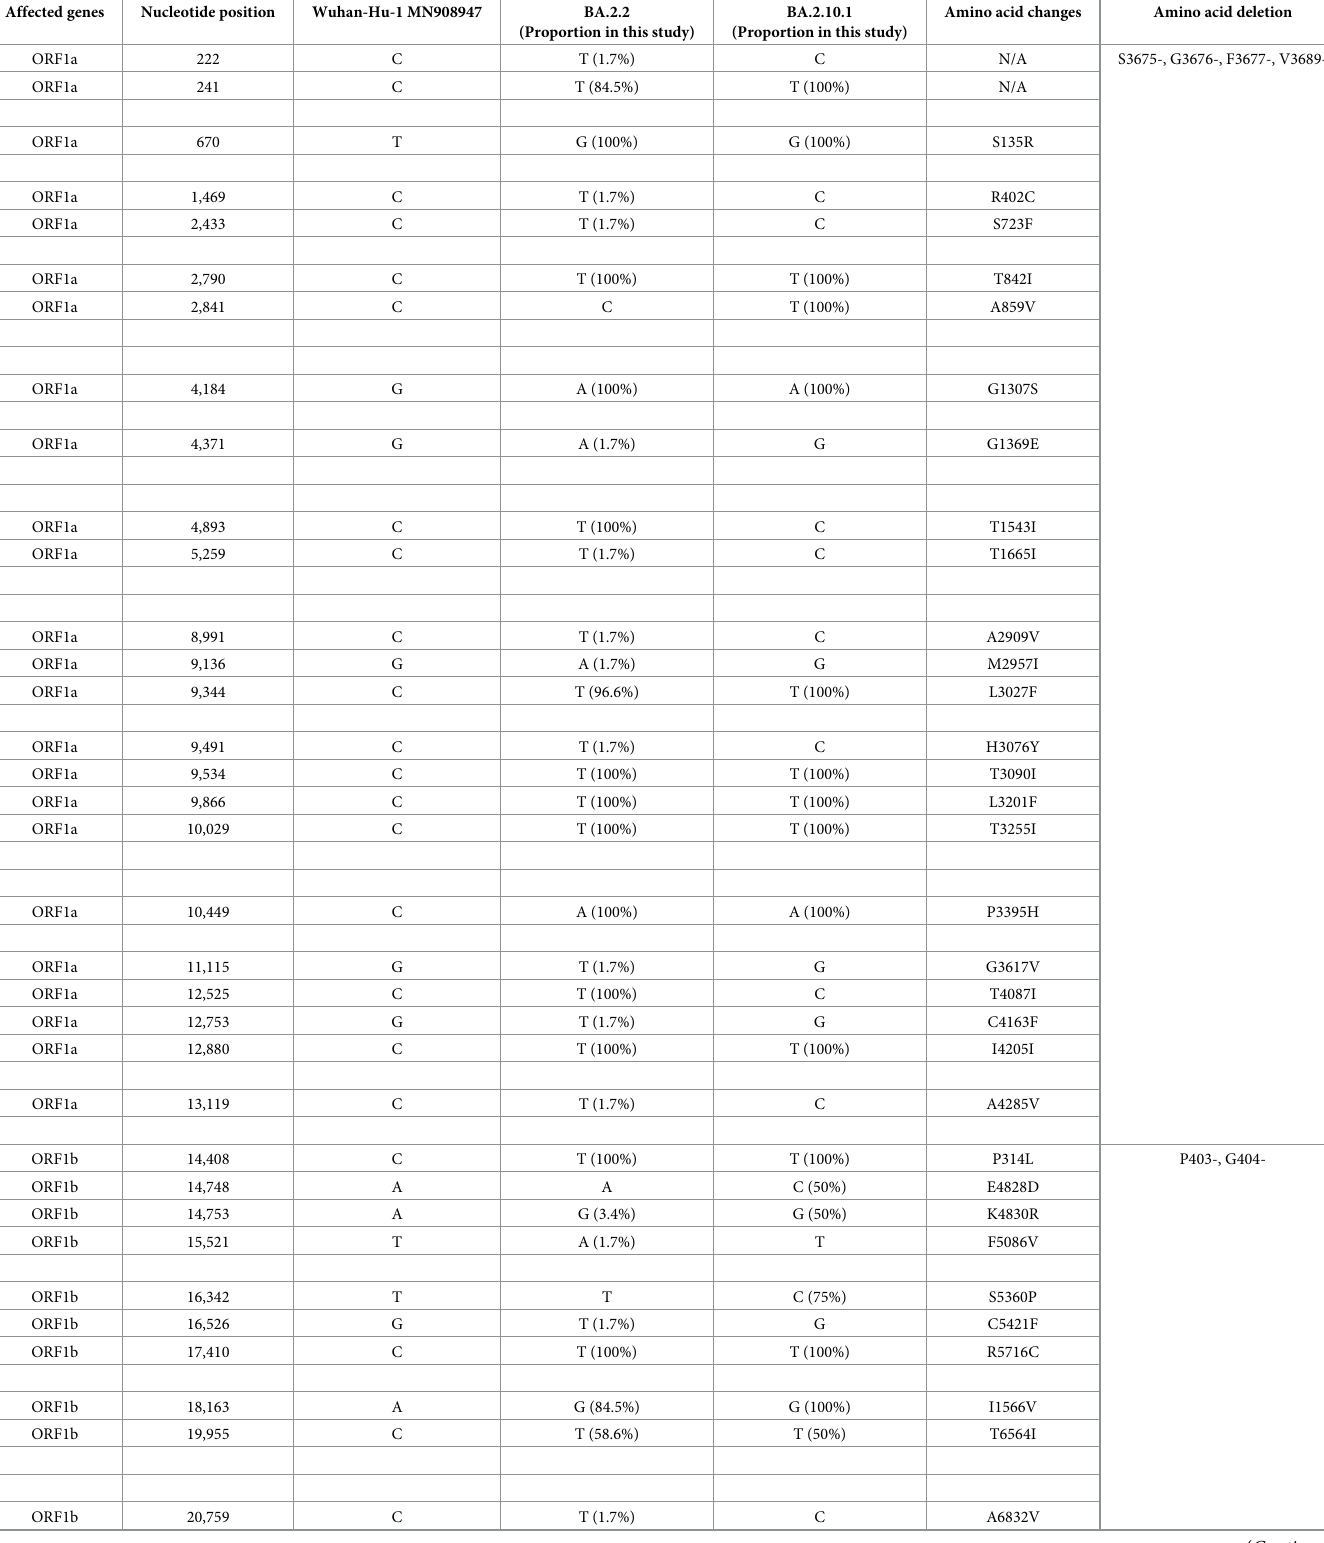
Table 3. Nucleotide and nonsynonymous amino acids mutations identified in the genome sequences of SARS-CoV-2 B.1.1.529 Omicron subvariants BA.2.2 and BA.2.10.1.